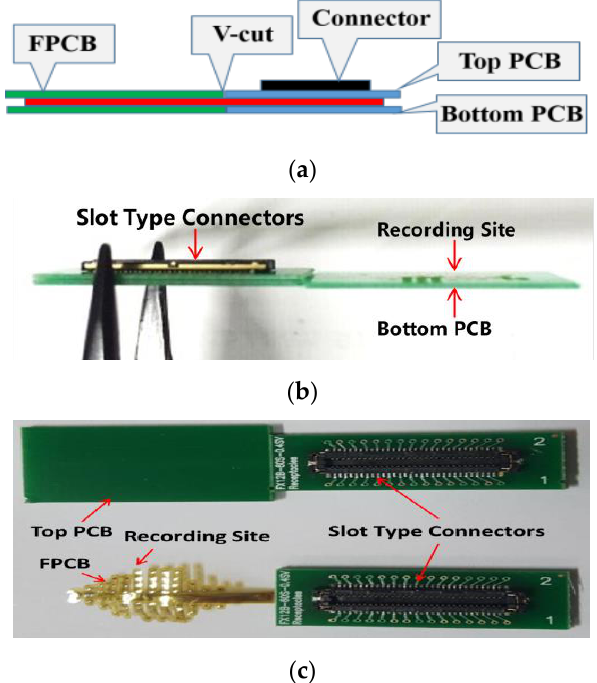
Figure 4. Images of the flexible MEAs mounted on the surface of a printed circuit board (PCB): ( a ) Schematic demonstration; ( b ) side view; and ( c ) top view.